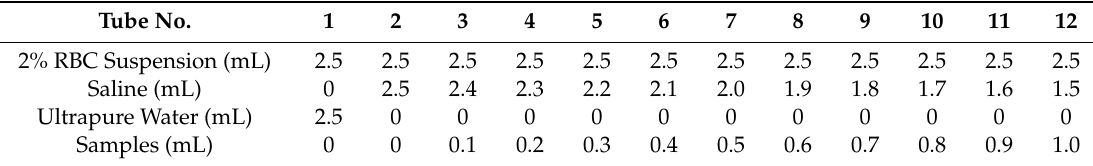
Table 1. Hemolysis test of